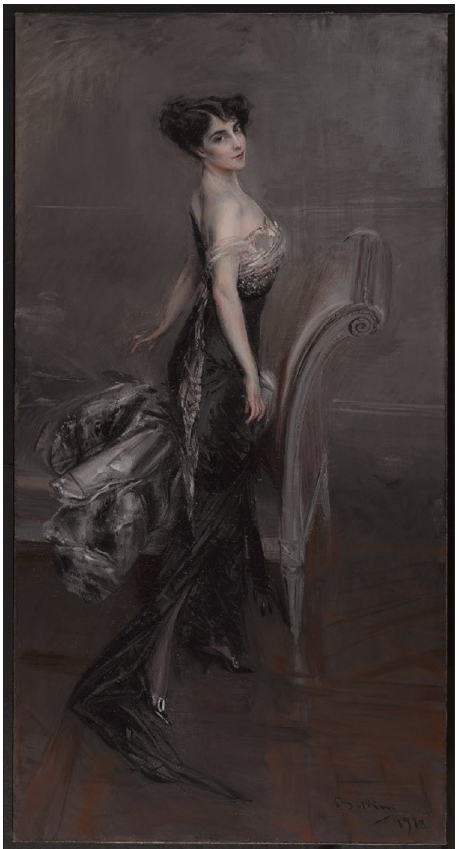
Fig. 7 : Giovanni Boldini, Portrait of a Lady , Paris, 1912, oil on canvas, 231.1 × 121.3 cm, Brooklyn Museum (inv.